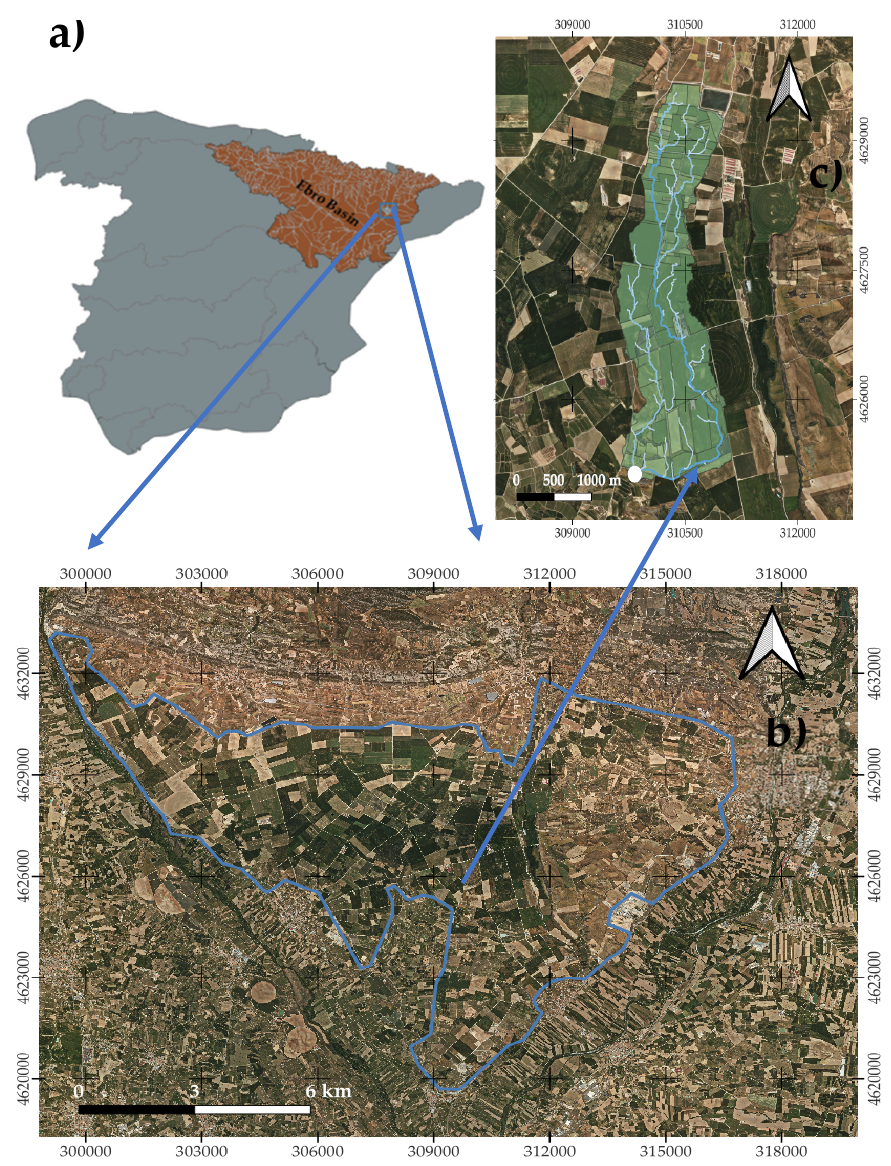
Figure 1. Study site showing in ( a ) the location of the study area in the Ebro Basin, ( b ) the Algerri- Balaguer irrigation district and ( c ) the AB5 sub-basin, drainage network, farm distribution and outlet position (white dot). Maps developed according to the Coordinate Reference System ETRS89/UTM zone 31N and Authority ID EPSG:25831.